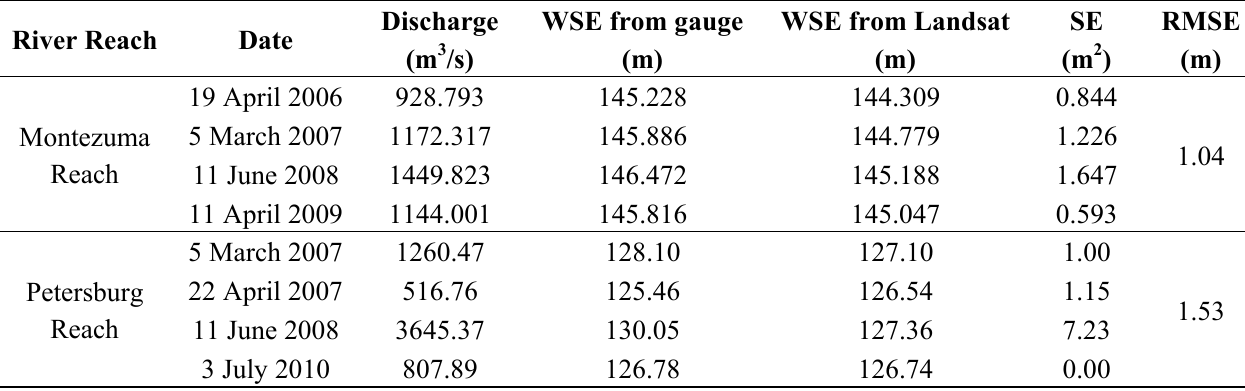
Table 2. Comparison of water surface elevations from gauge and Landsat